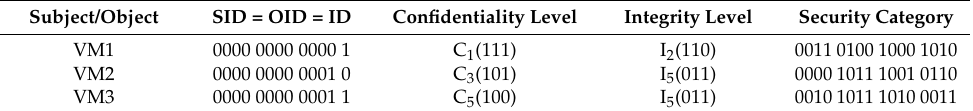
Table 5. Security settings of VM1, VM2, and VM3.